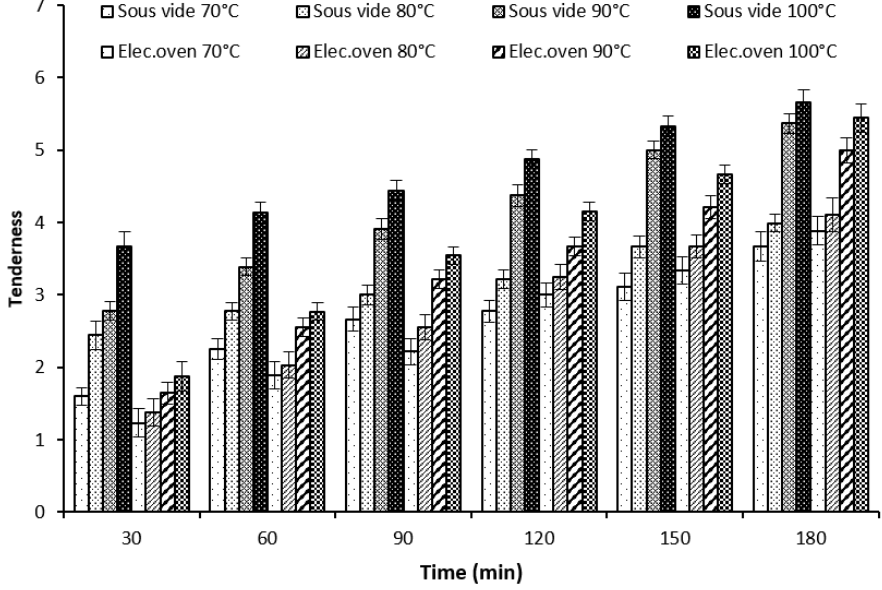
Figure 8. The effect of the cooking method (sous vide vs. electrical oven) on the camel meat sensory properties (tenderness) at different combinations of temperature and time.